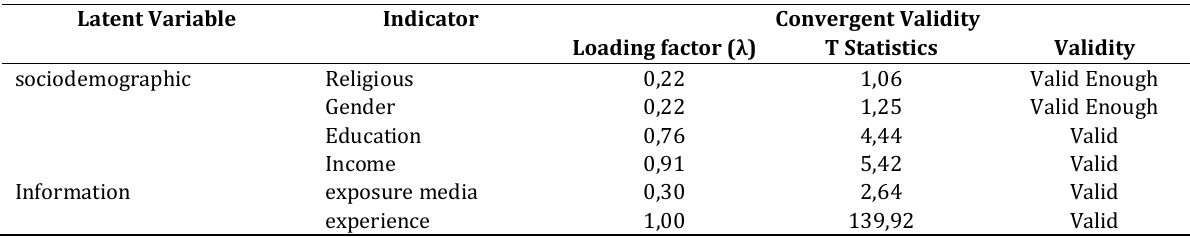
Table 2. Convergent validity of latent variables